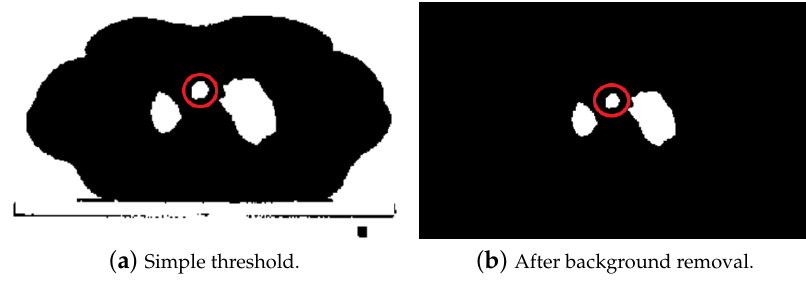
Figure 8. First steps of segmentation with